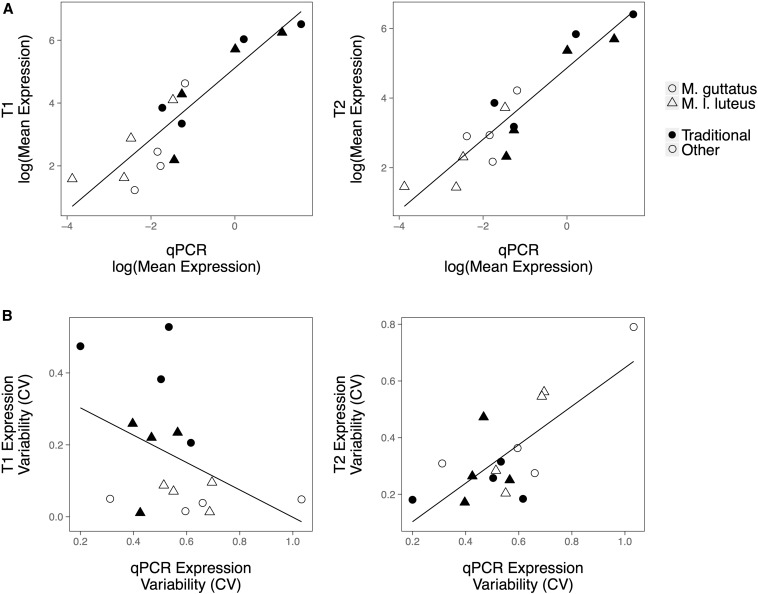
Comparisons of relative gene expression and of expression variability as determined by RNA-seq and qPCR for a sample of four traditional reference genes (closed symbols) and four additional genes that had initially been found to be stably expressed in transcriptome T1 (open symbols) (Table S3). The T2 RNA-seq transcriptomes and the qPCR data were derived from genetically identical plants grown in the same greenhouse, while the T1 RNA-seq transcriptomes were derived from plants grown in a greenhouse at a separate institution (Figure 1). (A) There is a strong correlation in relative expression determined by qPCR and RNA-seq, for both T1 (left panel, r = 0.90, P < 0.001) and T2 (right panel, r = 0.85, P < 0.001). (B) Expression variability (CV) measured via qPCR is correlated with expression variability measured via T2 (right panel, r = 0.74, P = 0.001), but is not correlated to expression variability measured via T1 (left panel, r = −0.42, P = 0.104). Expression data from both M. guttatus and M. l. luteus are included together. Relative expression of T1 and T2 is given in FPKM. Relative qPCR expression = EfficiencyΔCq, where ΔCq = CqCalibrator − Cqsample. CV, coefficient of variation; FPKM, fragments per kilobase per million reads; qPCR, quantitative polymerase chain reaction; RNA-seq, RNA sequencing.